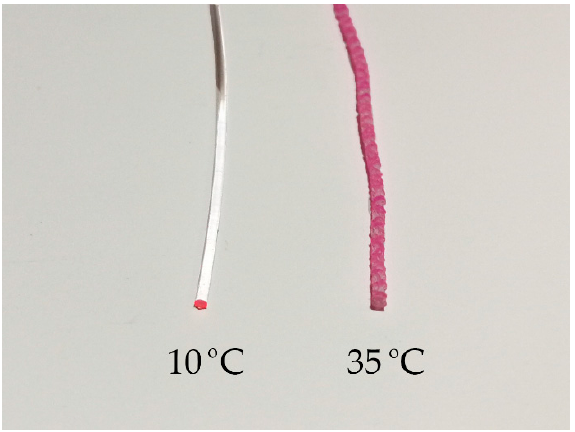
Figure 5. External appearance of two doped samples prepared at 10 °C and at 35 °C.